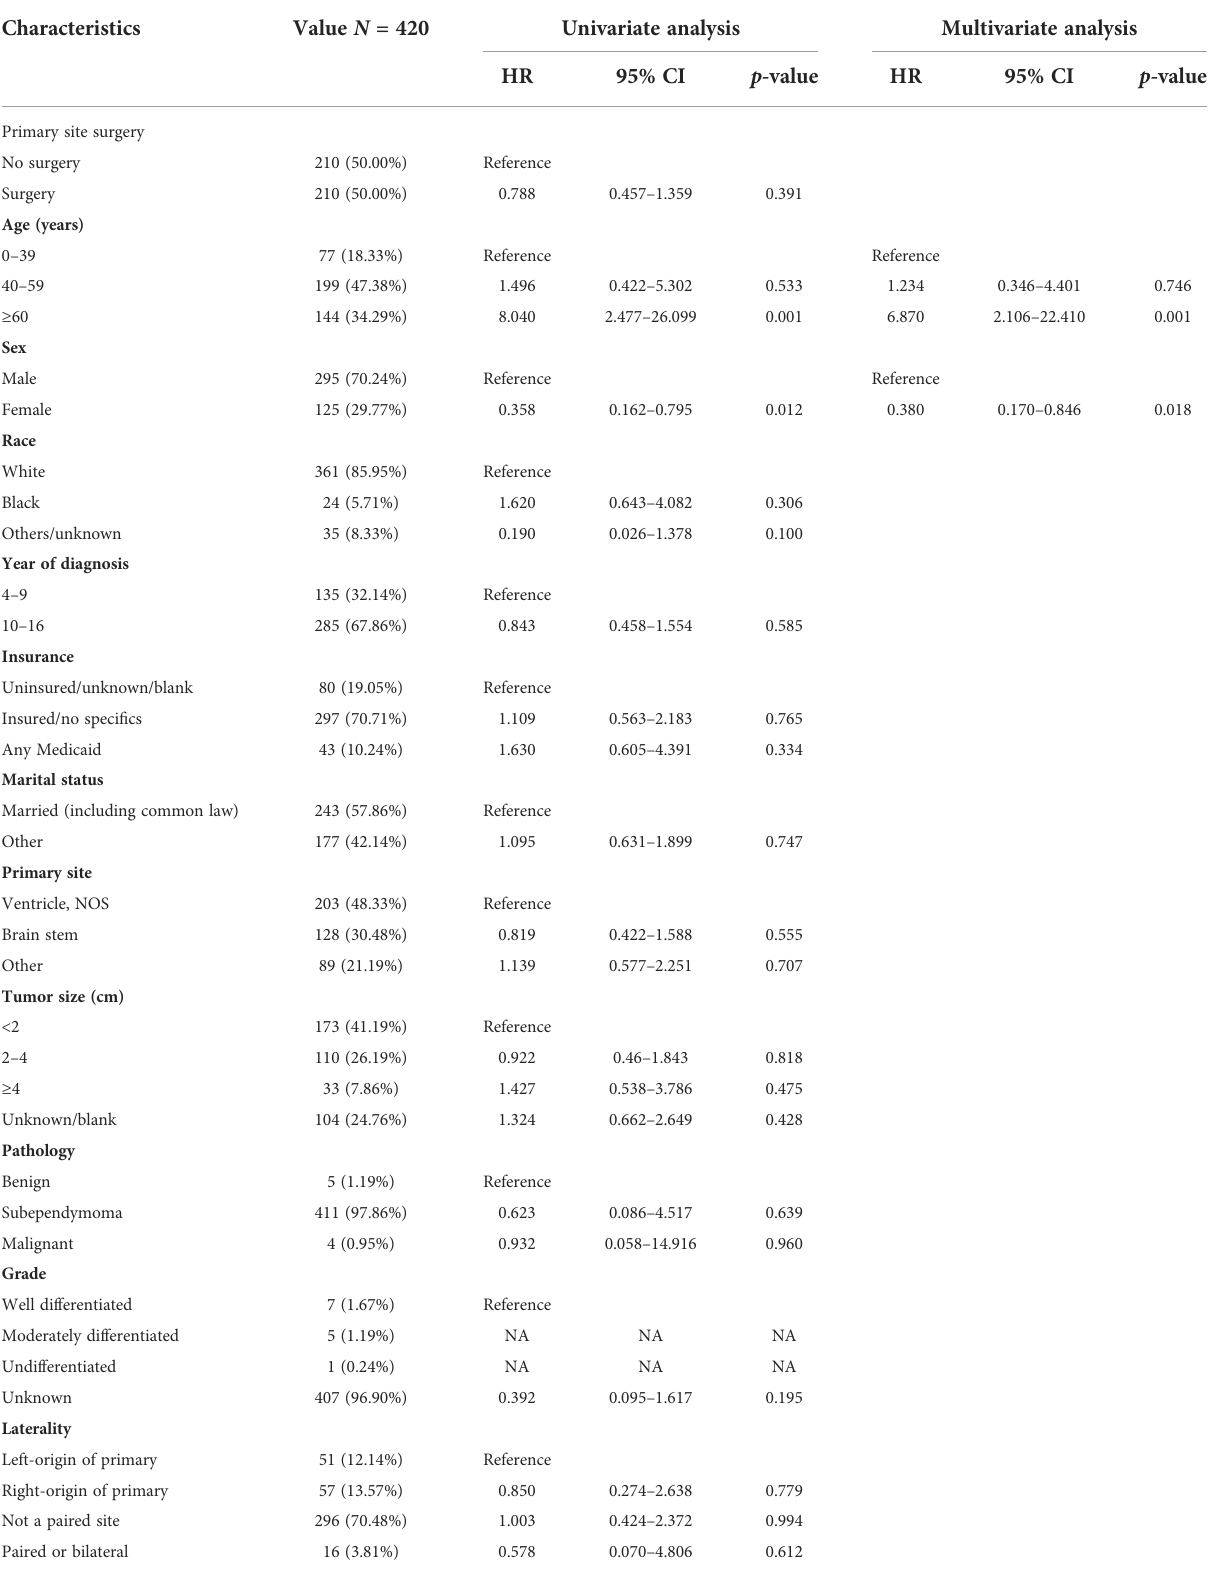
TABLE 3 The characteristics of 420 patients from the 667 patients grouped according to no surgery and surgery after